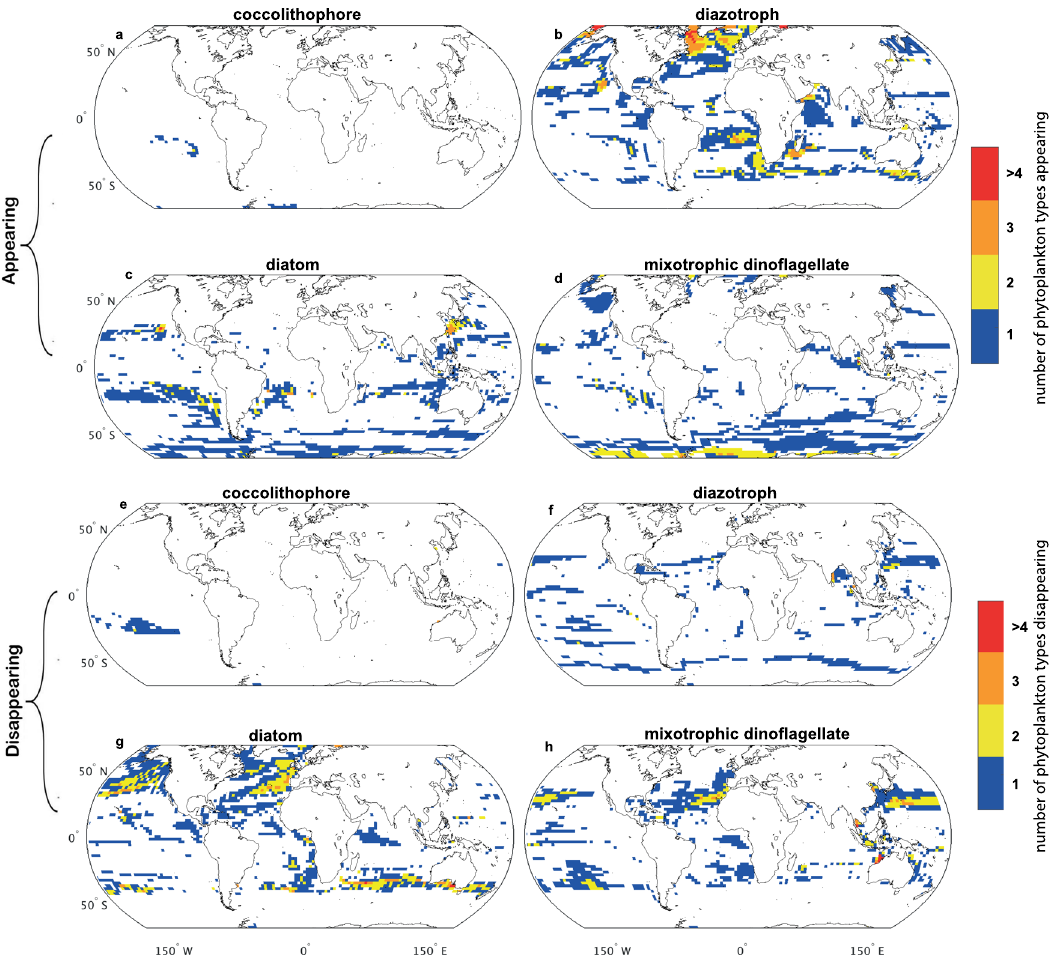
Fig. 2 Appearance and disappearance of phytoplankton types by the end of the century. The number of phytoplankton types appearing ( a – d ) and disappearing ( e – h ) between the baseline period (mean of 2005 − 2024) and end of century period (mean of 2081 − 2100) in each of six groups: coccolithophores ( a , e ), of which there are fi ve types; diazotrophs ( b , f ), of which there are fi ve types; diatoms ( c , g ), of which there are 11 types; mixotrophic dino fl agellates ( d , h ), of which there are 10 types. Prokaryotes and picoeukaryotes (of which there are two types of each) do not show any signi fi cant changes. Appearance (disappearance) is de fi ned as a type contributing >0.1% (<0.1%) to total